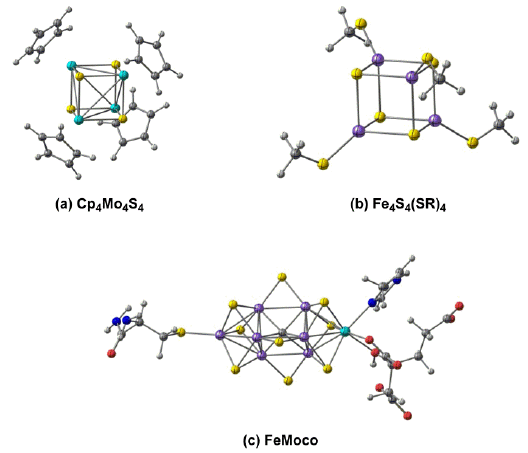
Figure 1. Clusters with cubane-like architectures: ( a ) the Cp 4 M 4 E 4 architecture, ( b ) the Fe 4 S 4 cubanes and ( c ) the FeMo cofactor of nitrogenase.